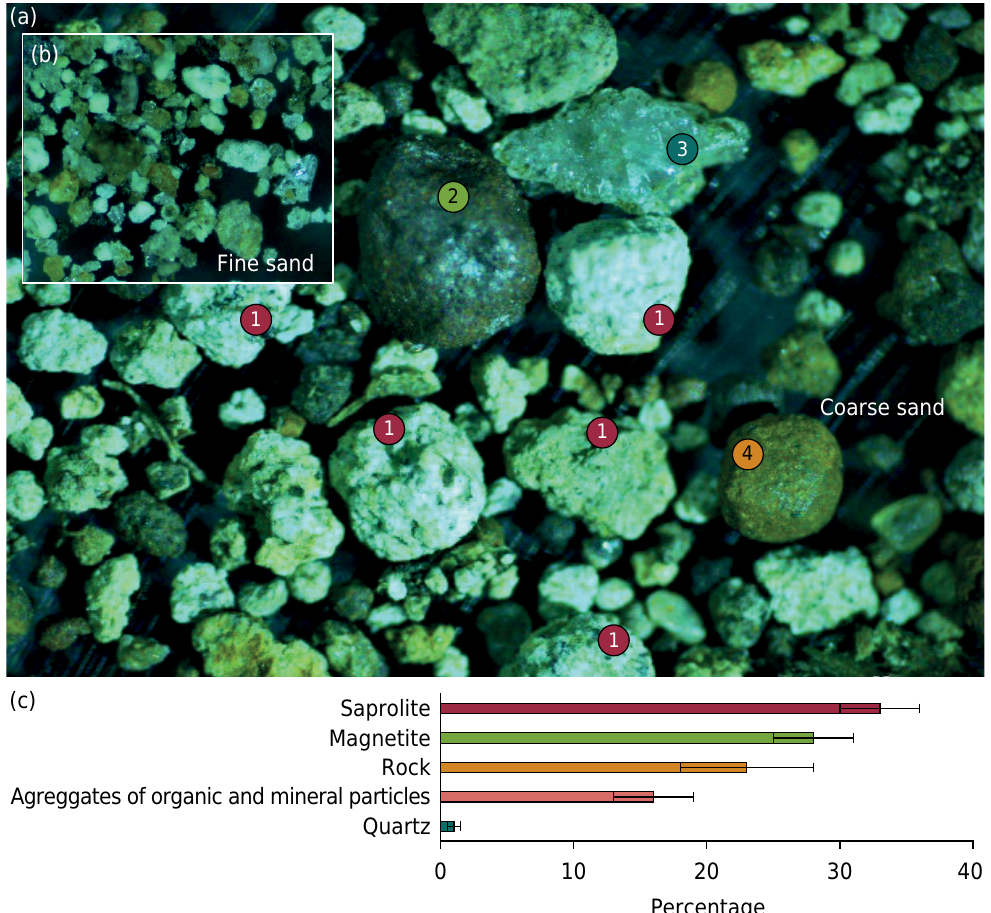
Figure 3. A representative image of the coarse sand components captured with a Zeiss Stemi 508 stereo microscope (Carl Zeiss Microscopy GmbH, Jena, Germany) at 50× magnification (a) and fine sand (b). The numbers 1, 2, 3 and 4 indicate saprolite, magnetite, quartz and rock fragments, respectively. (c) Percentage of mineral fractions in coarse sand dispersed with US at 70 and 110 J mL -1 and HS for 1, 2, 4, 8 and 16 h. N = 42. Bars in the columns represent the standard